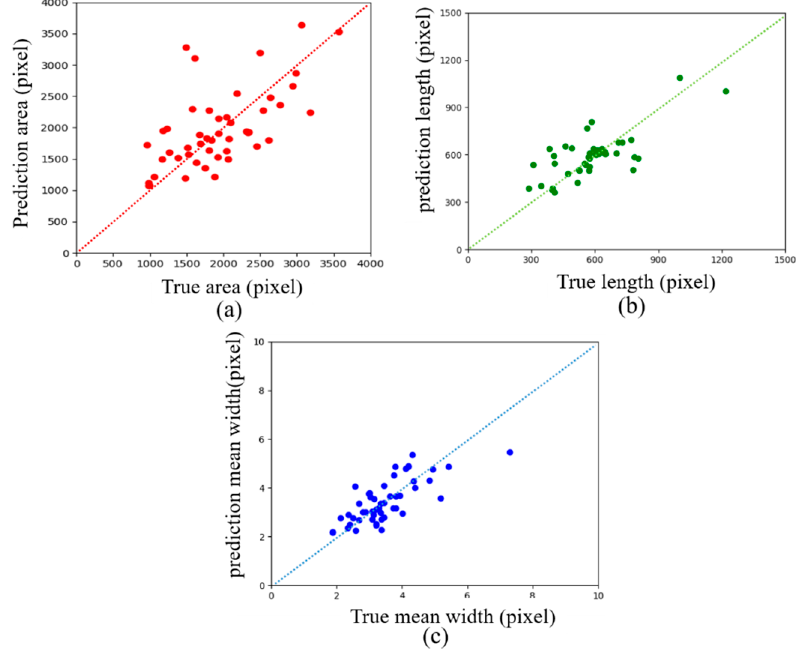
Figure 14. Statistics of crack size in test dataset: ( a ) crack area, ( b ) crack length, ( c ) crack mean width.